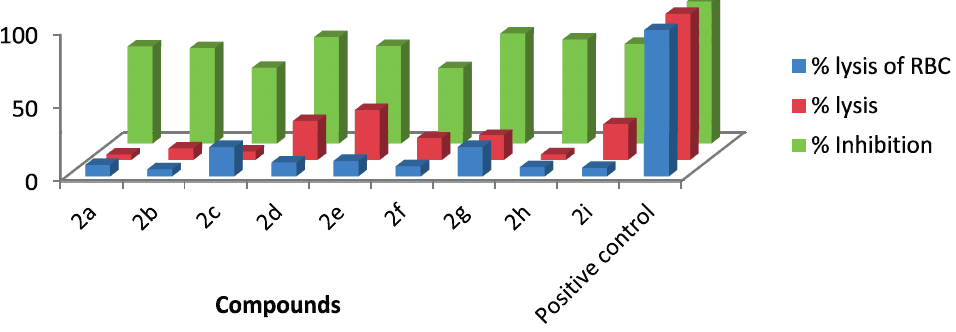
Figure 1. Values of haemolytic, anti-thrombolytic and biofilm inhibition activities.